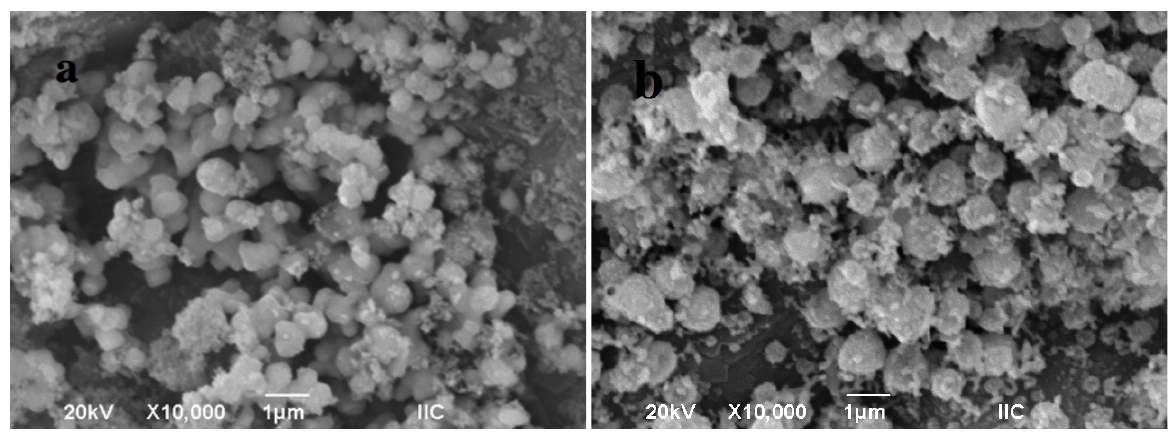
Figure 3. SEM micrographs of ( a ) Ni; and ( b ) Cu particles on